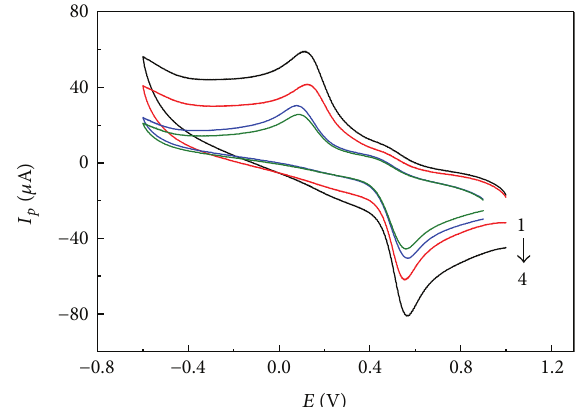
Figure 7: Cyclic voltammograms of poly-L-histidine modified elec- trodes in different pH (1.0 ∼ 4.0)